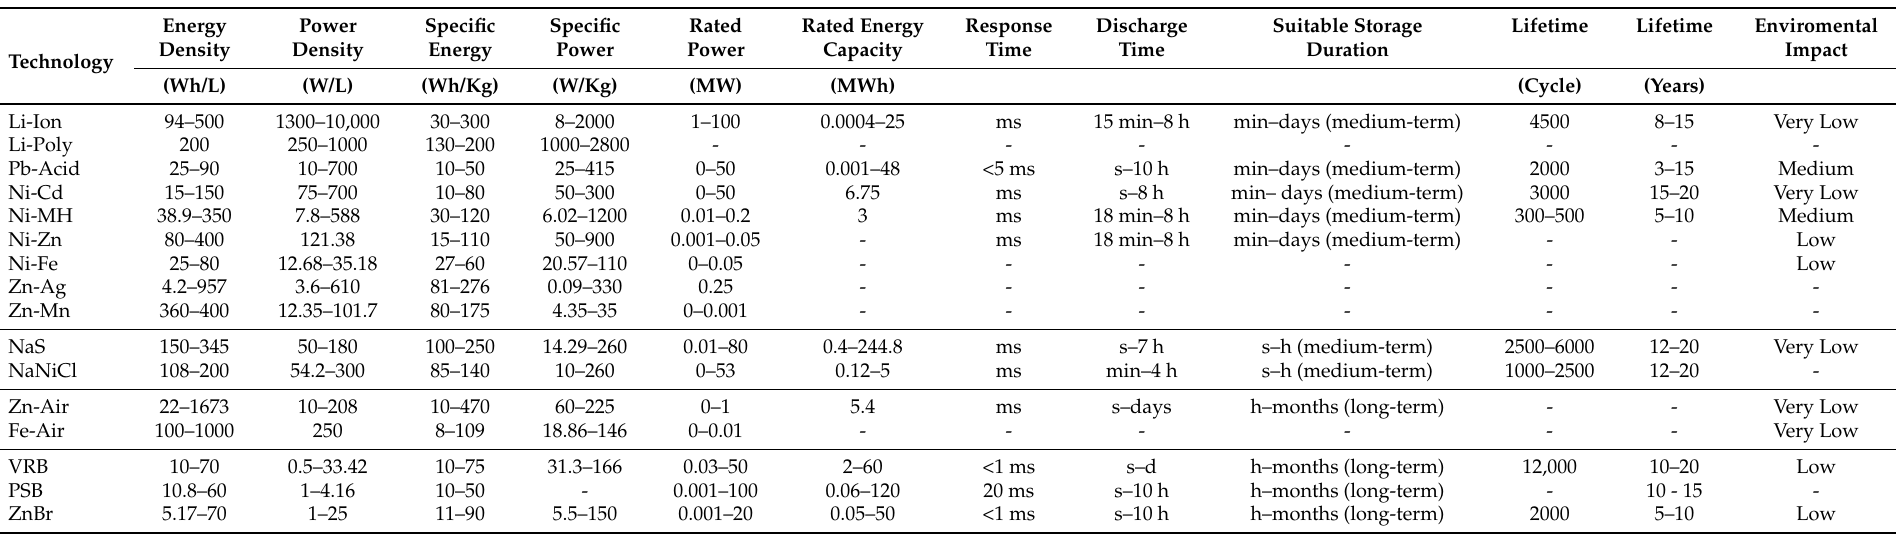
Table 3. Technical Characteristics of